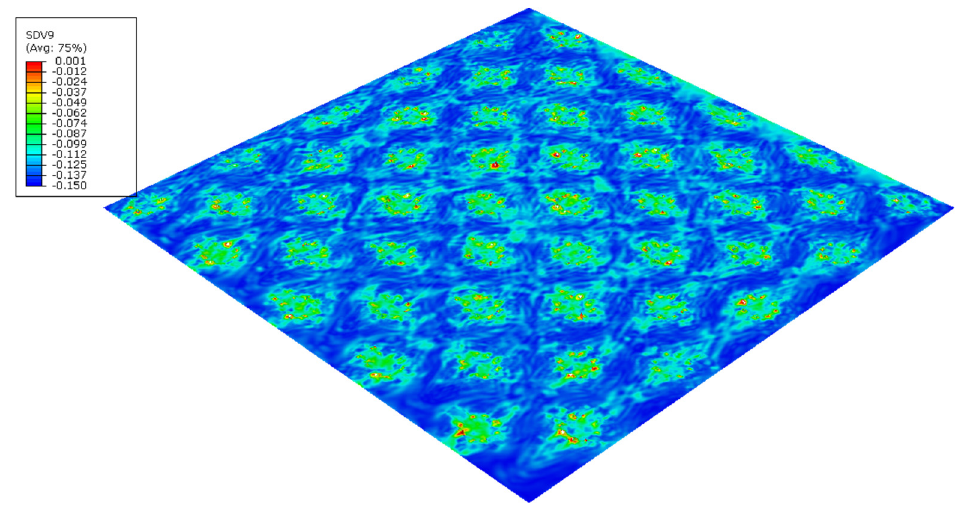
Figure 21. Plastic-stress-field finite-element results for micropattern with straight finishing.